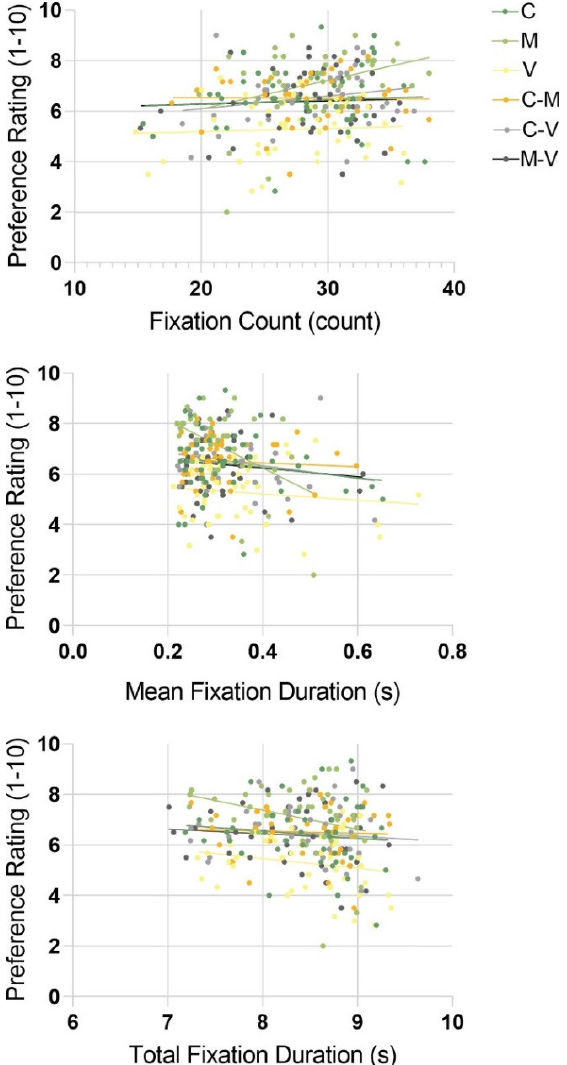
Figure 7. Correlations between preference ratings and gaze metrics of vegetation landscapes com- posed of plants of different geometrical forms.